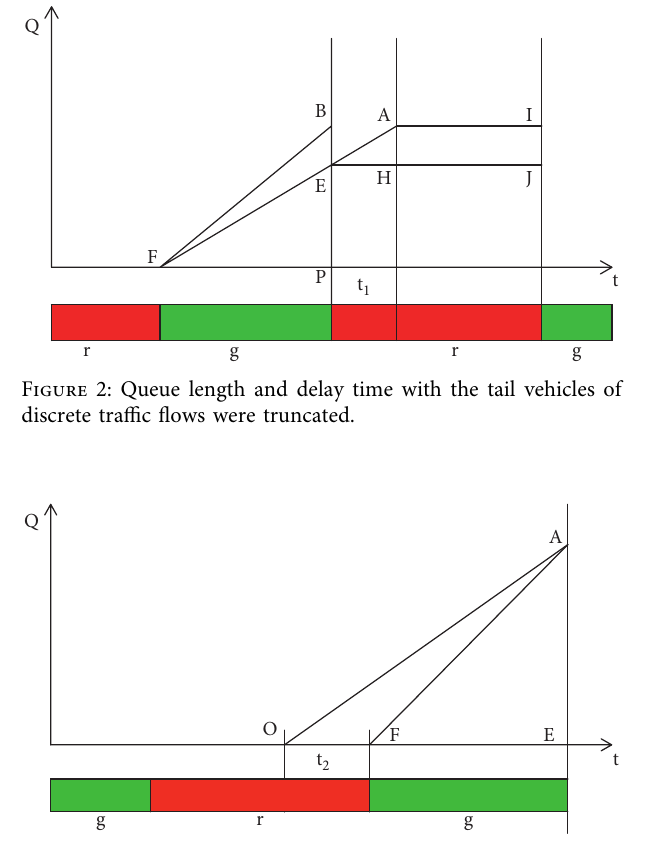
Figure 3: Queue length and delay time with the front vehicles of discrete traffic flows were